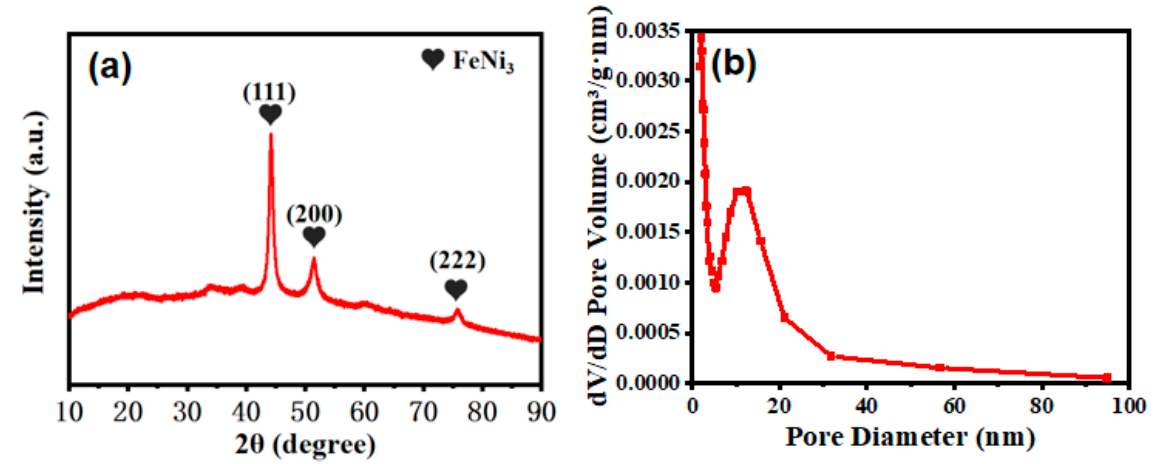
Figure 1. XRD diffraction ( a ) and porosity test results ( b ) of FeNi 3 alloy sample. The porosity test result of the FeNi 3 alloy sample is shown in Figure 1b. As can be seen, most of the voids are distributed in the range of 10–20 nm. At the same time, the density of the FeNi 3 alloy was prepared by the density tester (G-DenPyc 2900 true, China) with the gas displacement method at 25 ◦ C. The results of the three measurement times show that the density of the prepared sample was 5.84 (g/mL). The SEM images of the FeNi 3 composites are shown in Figure 2a,b. By looking at the SEM images, it can be seen that most of the particles appear spherical with well-defined particles. The size of the particle spheres is relatively uniform, with most of them having diameters between 90–100 nm, which corresponds to the XRD results. The surfaces of the granular spheres have rough surfaces with polyhedral edges and corners, and a small number of particles exhibit overlapping lamellar structures, which may be caused by the overlap between particles.